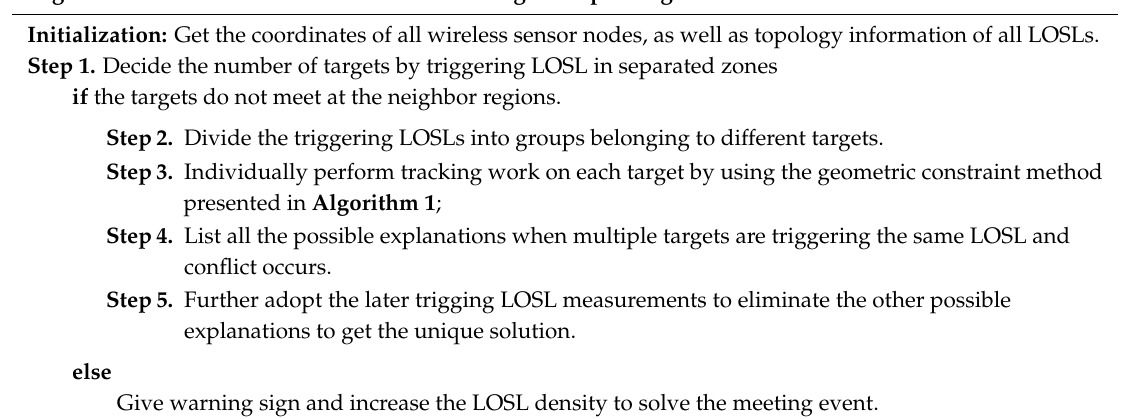
Algorithm 2. The CP Determination for Tracking Multiple